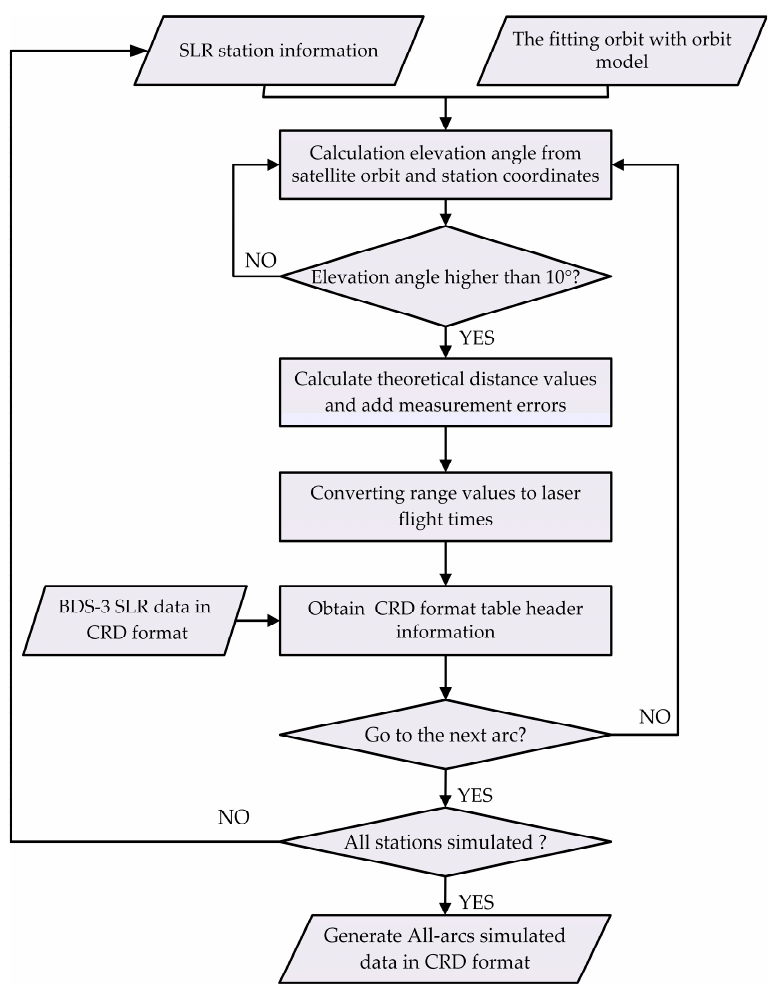
Figure 12. The simulation process of SLR data based on all-arcs